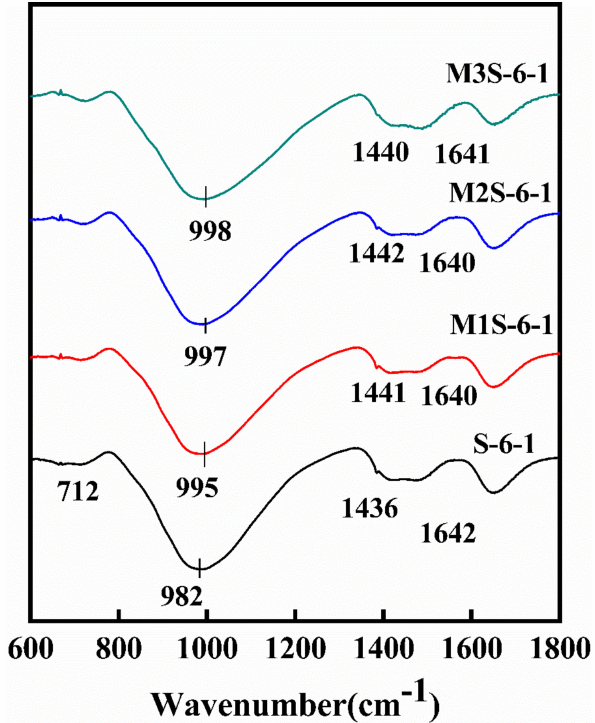
Figure 12. FTIR spectra of alkali-activated slag with different metakaolin contents.